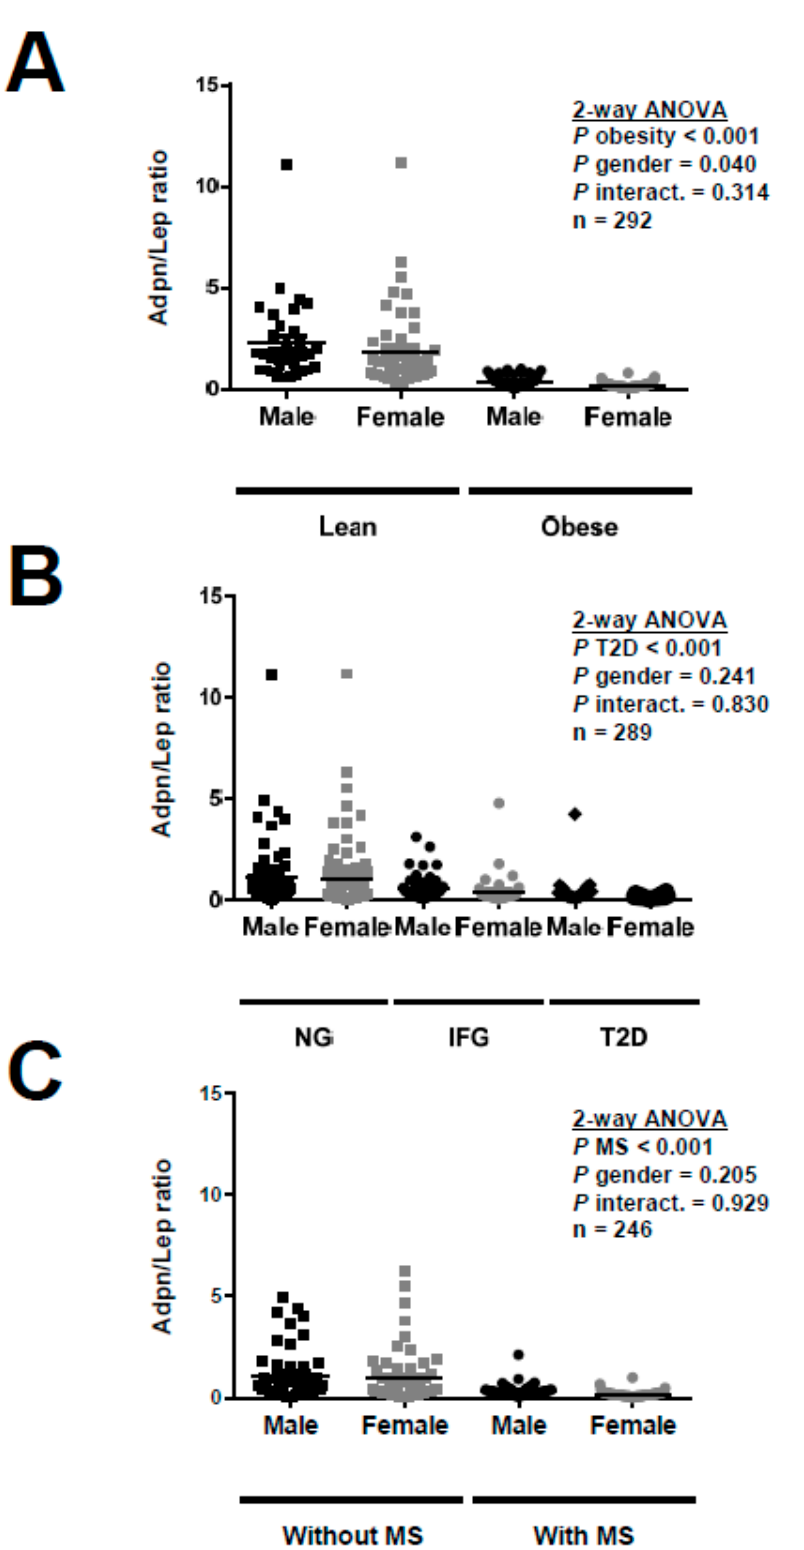
Figure 1. Adiponectin/Leptin (Adpn/Lep) ratio according to gender and ( A ) obesity ( n = 292), ( B ) type 2 diabetes ( n = 289) and ( C ) metabolic syndrome ( n = 246). Differences between groups were analyzed by two-way ANOVA. NG, normoglycemia; IFG, impaired fasting glucose; T2D, type 2 diabetes; MS, metabolic syndrome.